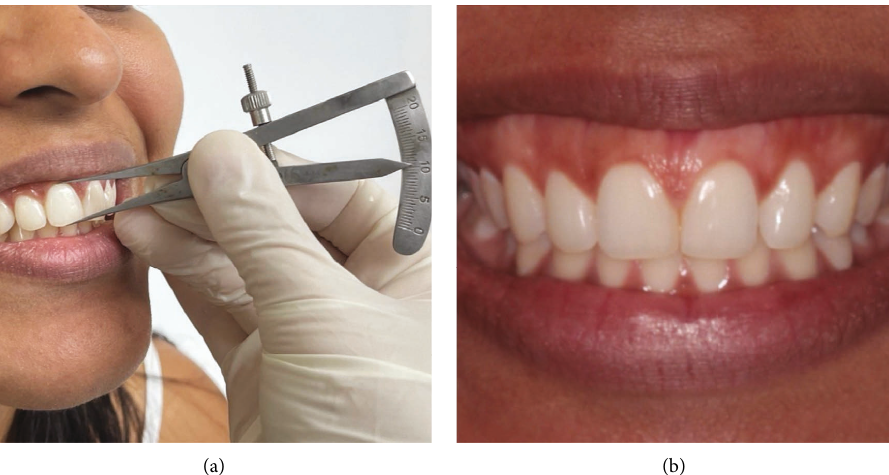
Figure 1: Patient’s picture before surgery. (a) Measurement of the length of the patient’s upper right central incisor. (b) Patient’s picture at the maximum smile.